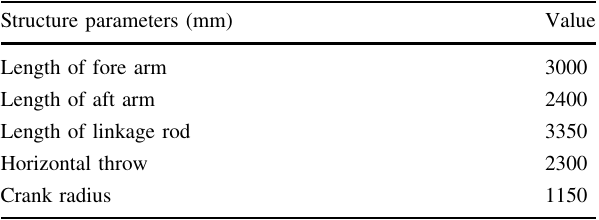
Table 1 Structure parameters and working parameters of CYJ10-3-